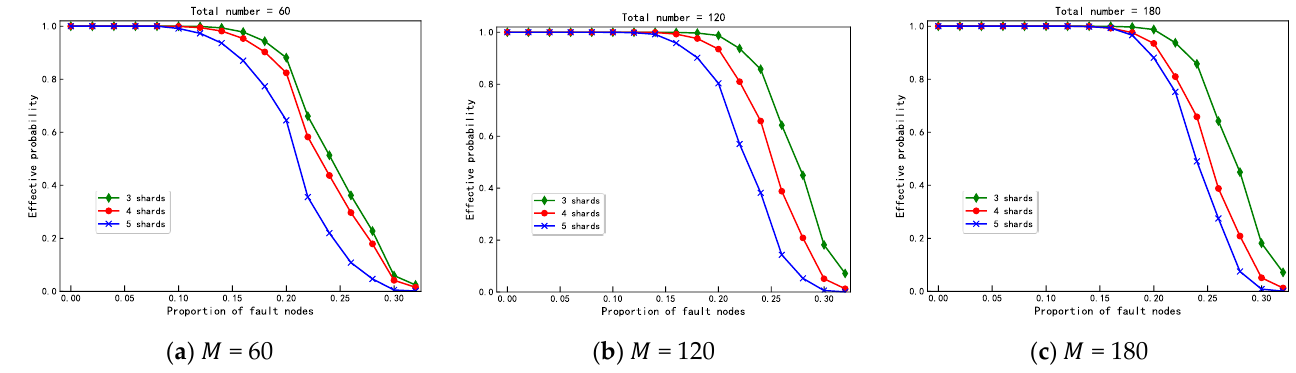
Figure 10. Analysis of the overall effectiveness of the system based on the scale of shards.